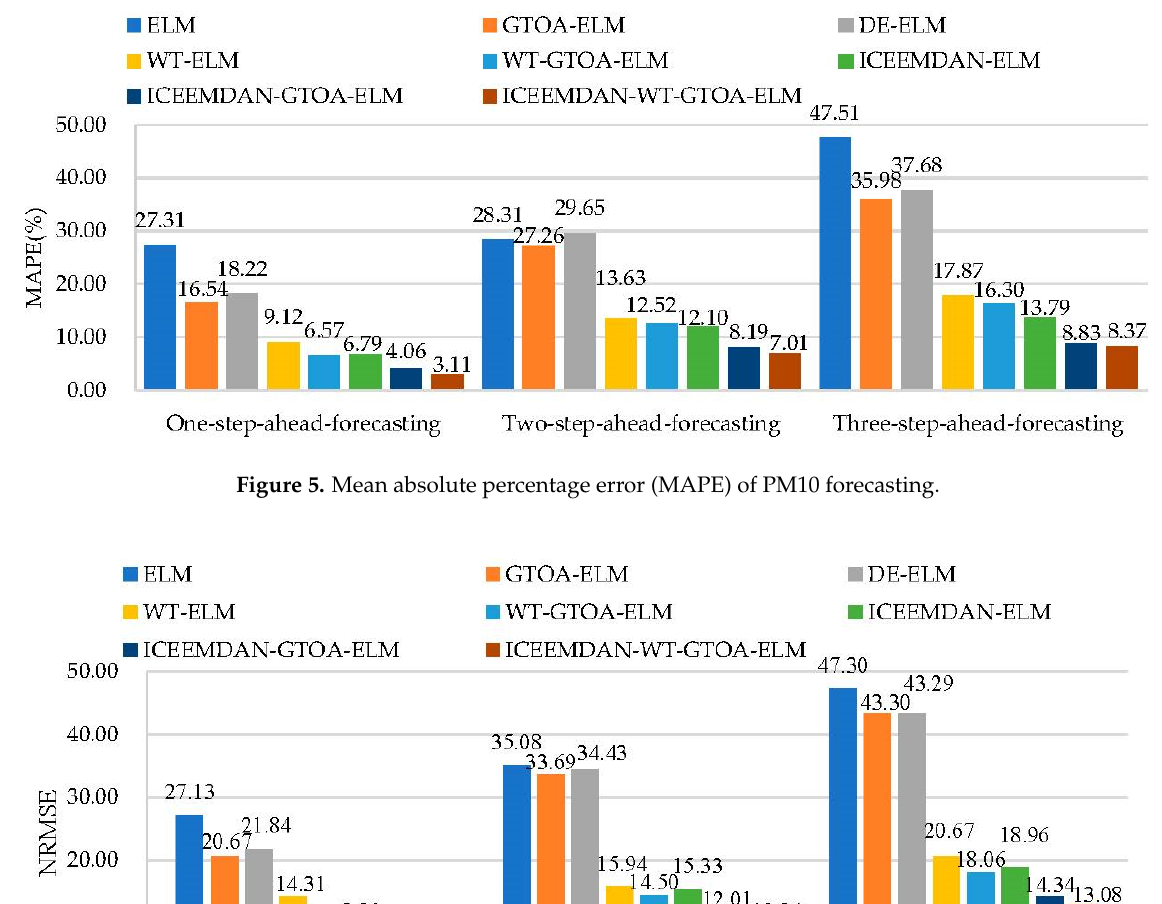
Figure 7. Theil’s coefficient (TIC) of PM10 forecasting. Figure 8. Direction statistics (Ds) of PM10 forecasting.